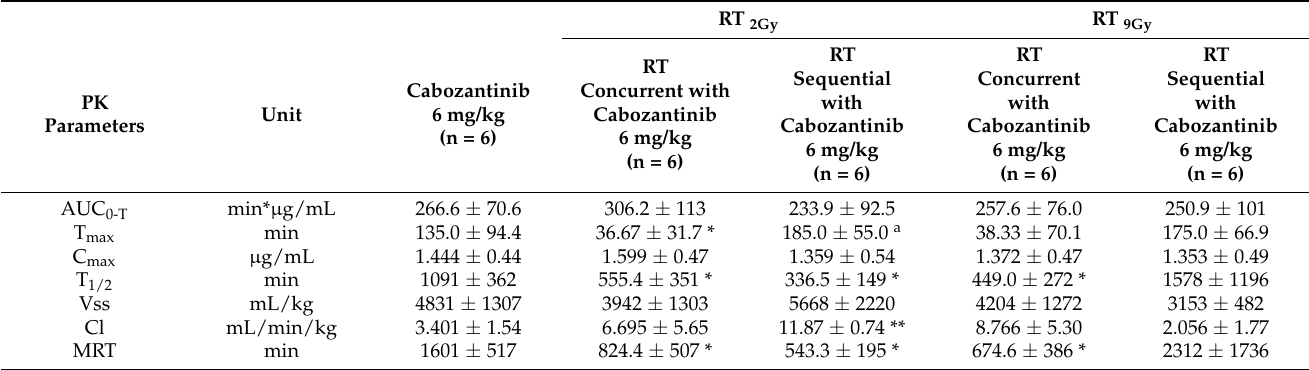
(Figure 2B, Table 1). Table 1. Pharmacokinetic parameters of cabozantinib in rats after administration for 3 days (6 mg/kg p.o., q.d.) with or without radiotherapy (RT, 2 Gy and 9 Gy). RT 2Gy RT